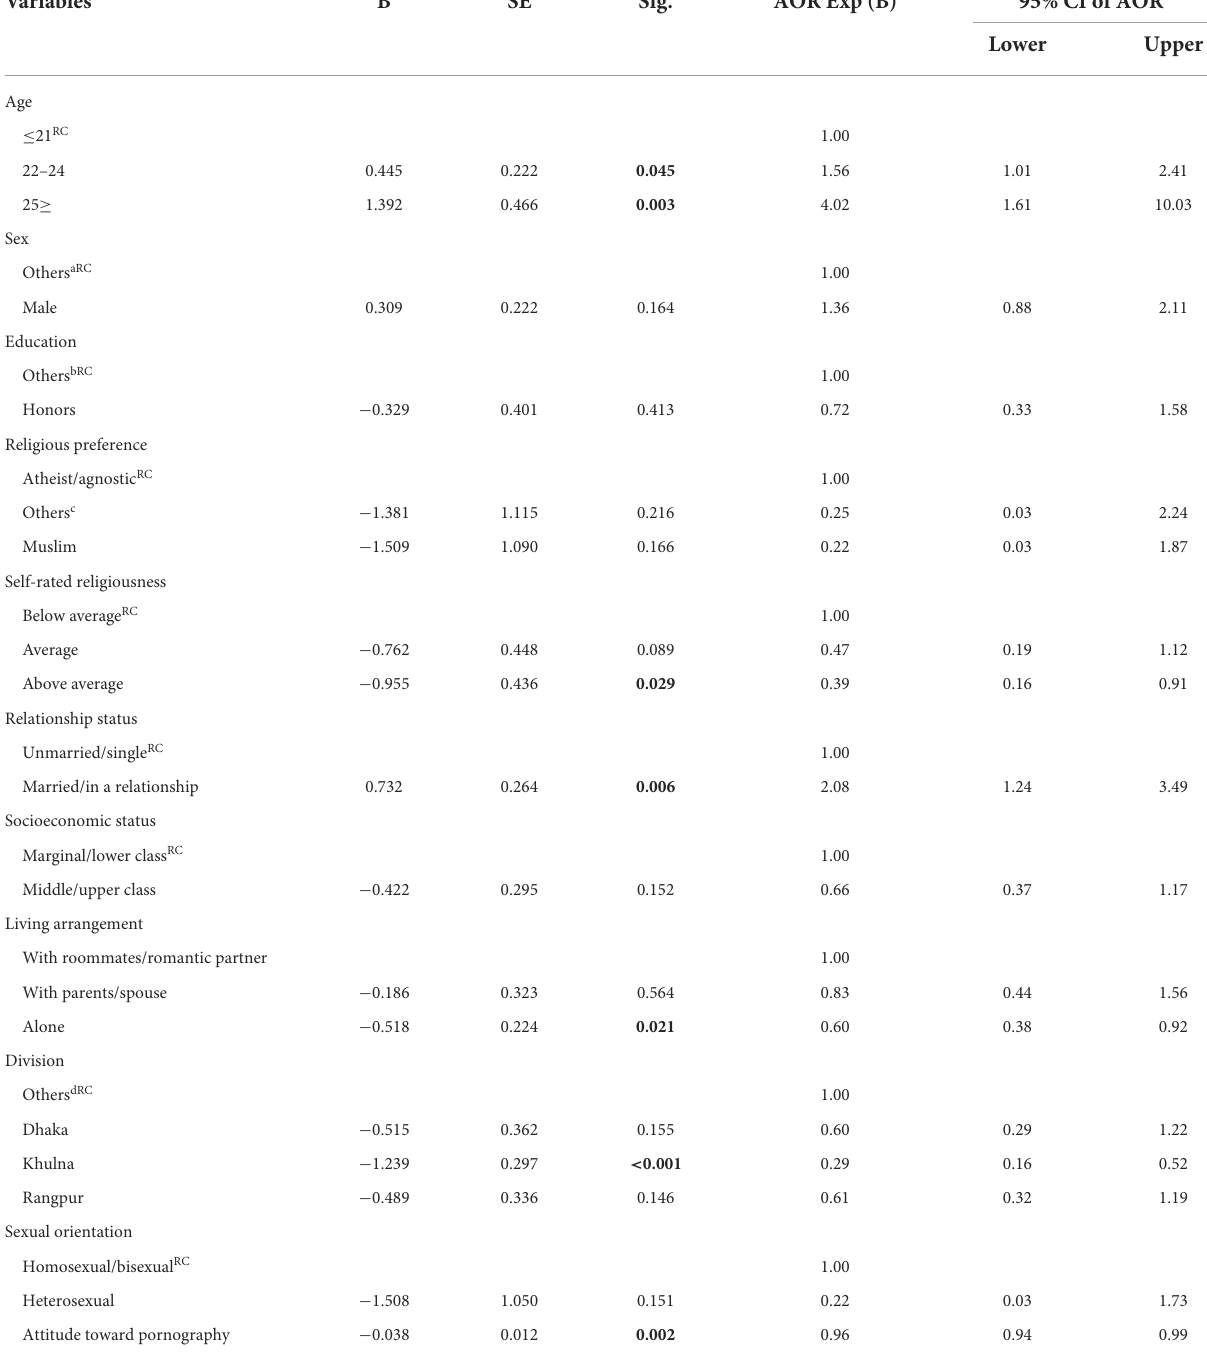
TABLE 2 Multiple logistic regression analysis of variables associated with exposure to